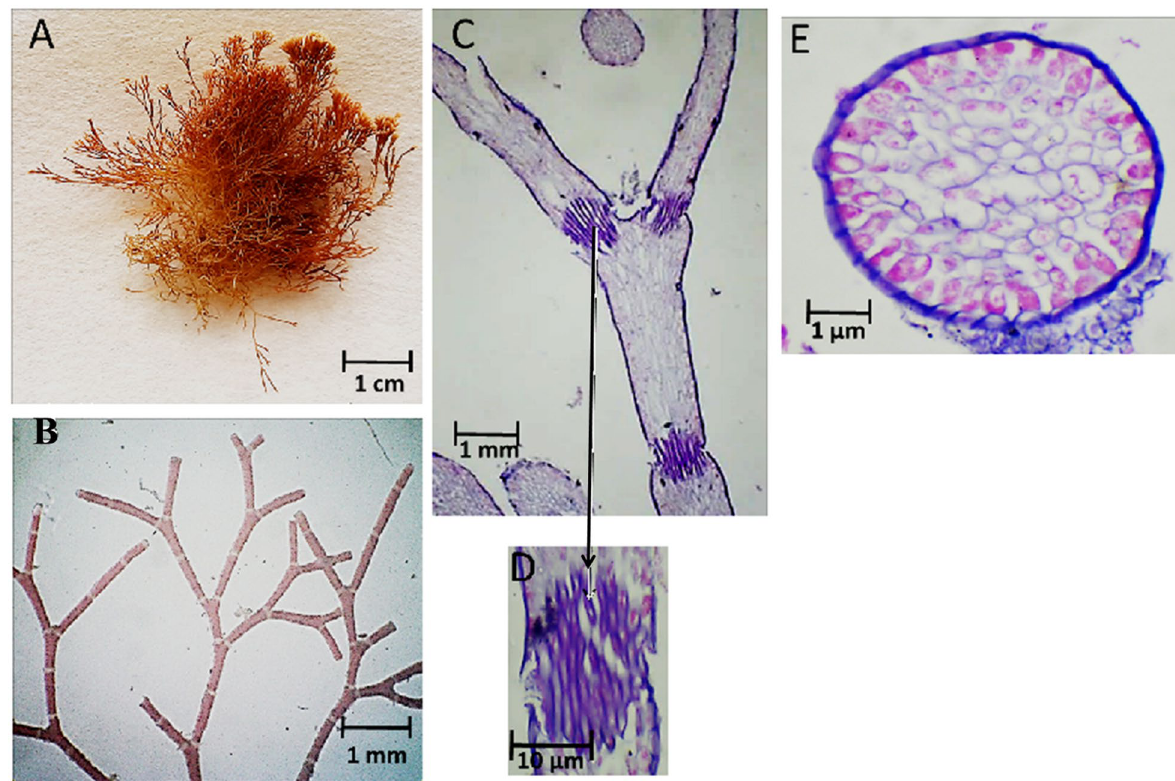
Fig. 6 Morphological and anatomical description of J. rubens thallus during autumn 2019. A Habit view of thallus, B Magnification of the thallus frond, C L.S. in thallus showing genicula and intergenicula tiers, D ) Magnification of mature geniculum, E and E Cross-section through intergeniculum